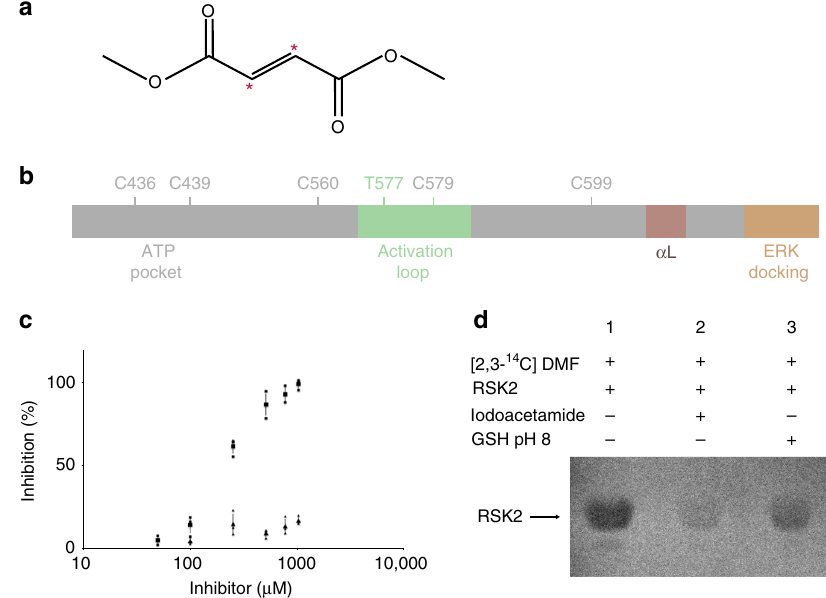
Fig. 1 DMF inhibits RSK2. a DMF with Michael acceptor reactive carbons marked with red asterisks. b Schematic representation of RSK2 CTKD and position of cysteine residues. c Inhibition of RSK2 CTKD by DMF (squares) and MMF (triangles). Error bars indicate the standard deviation of mean values ( n = 3, all data points included). d Covalent modi fi cation of RSK2 CTKD by DMF. Puri fi ed murine RSK2 (5 nmol) was incubated with 14 C-labelled DMF (25 nmol). DMF binding is reduced by preincubation of RSK2 with 10-fold molar excess of iodoacetamide or GSH, respectively. The + and – signs represent inclusion